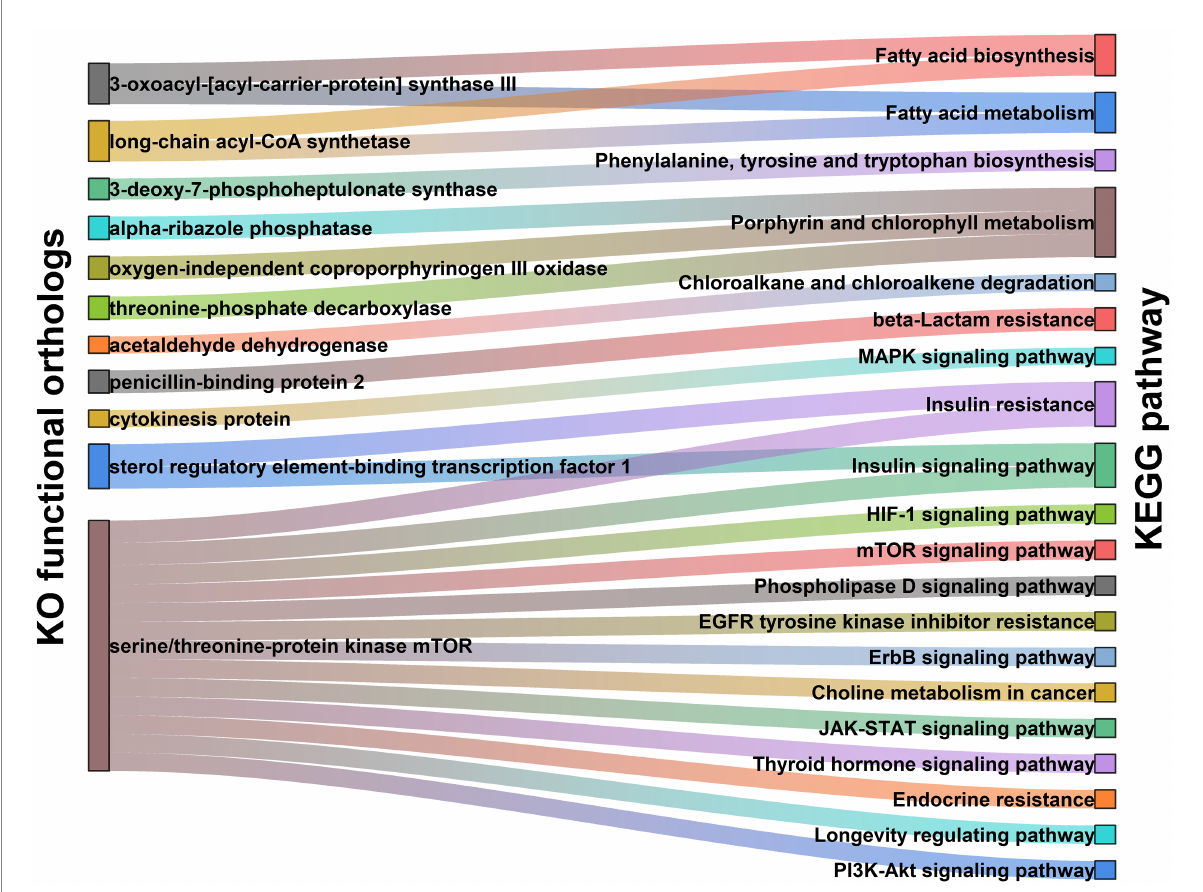
FIGURE 2 Functional module network of the differential microbiota in PCOS, including Kyoto Encyclopedia of Genes and Genomes (KEGG) Orthology (KO) functional orthologs (Left) and KEGG pathway (Right). Two nodes are connected when they show the direct interaction in KEGG database. The line width stands for the abundance of each metabolic